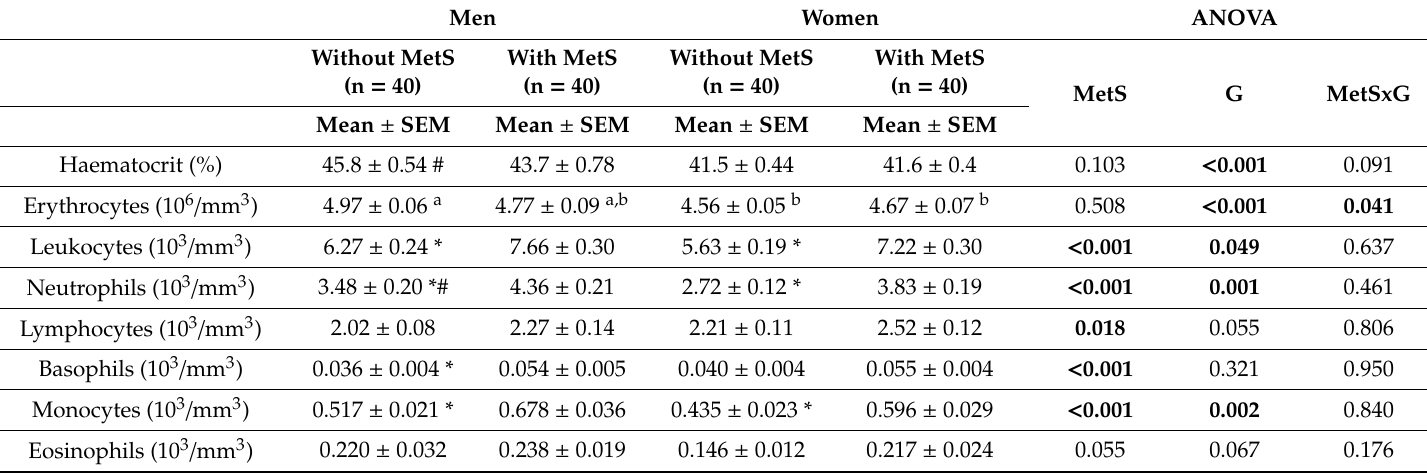
Table 2. Hematological parameters of participants “without Metabolic Syndrome” (n = 80) and “with Metabolic Syndrome” (n = 80) stratified by gender.